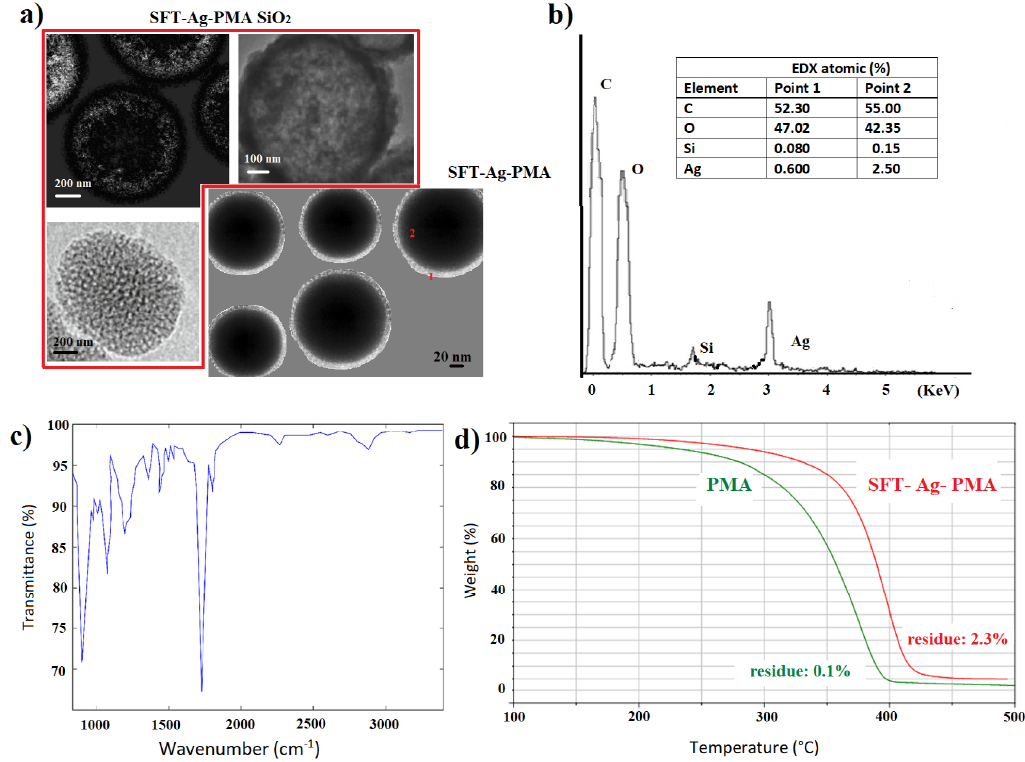
Figure 4. TEM images of SFT-Ag-PMA SiO 2 and SFT-Ag-PMA capsules ( a ); EDX and FTIR spectra of SFT-Ag-PMA capsules ( b , c ). TGA profiles of PMA (green) and SFT-Ag-PMA (red) capsules ( d